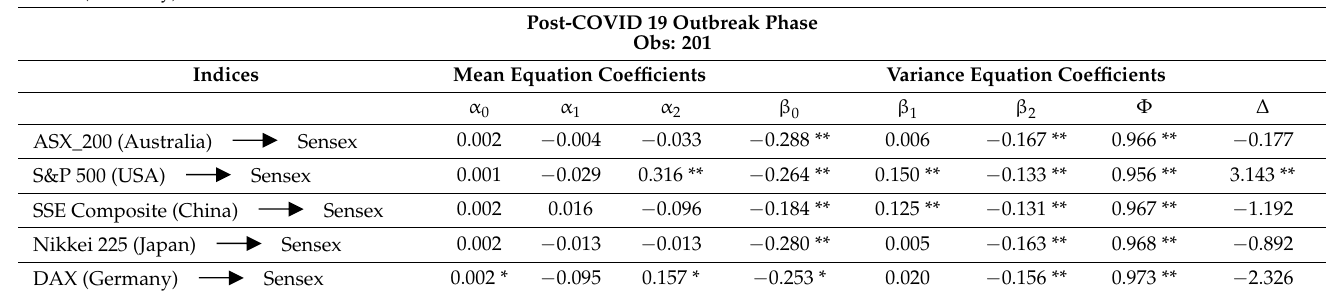
Table 6. Volatility spillover from foreign markets to Indian market.